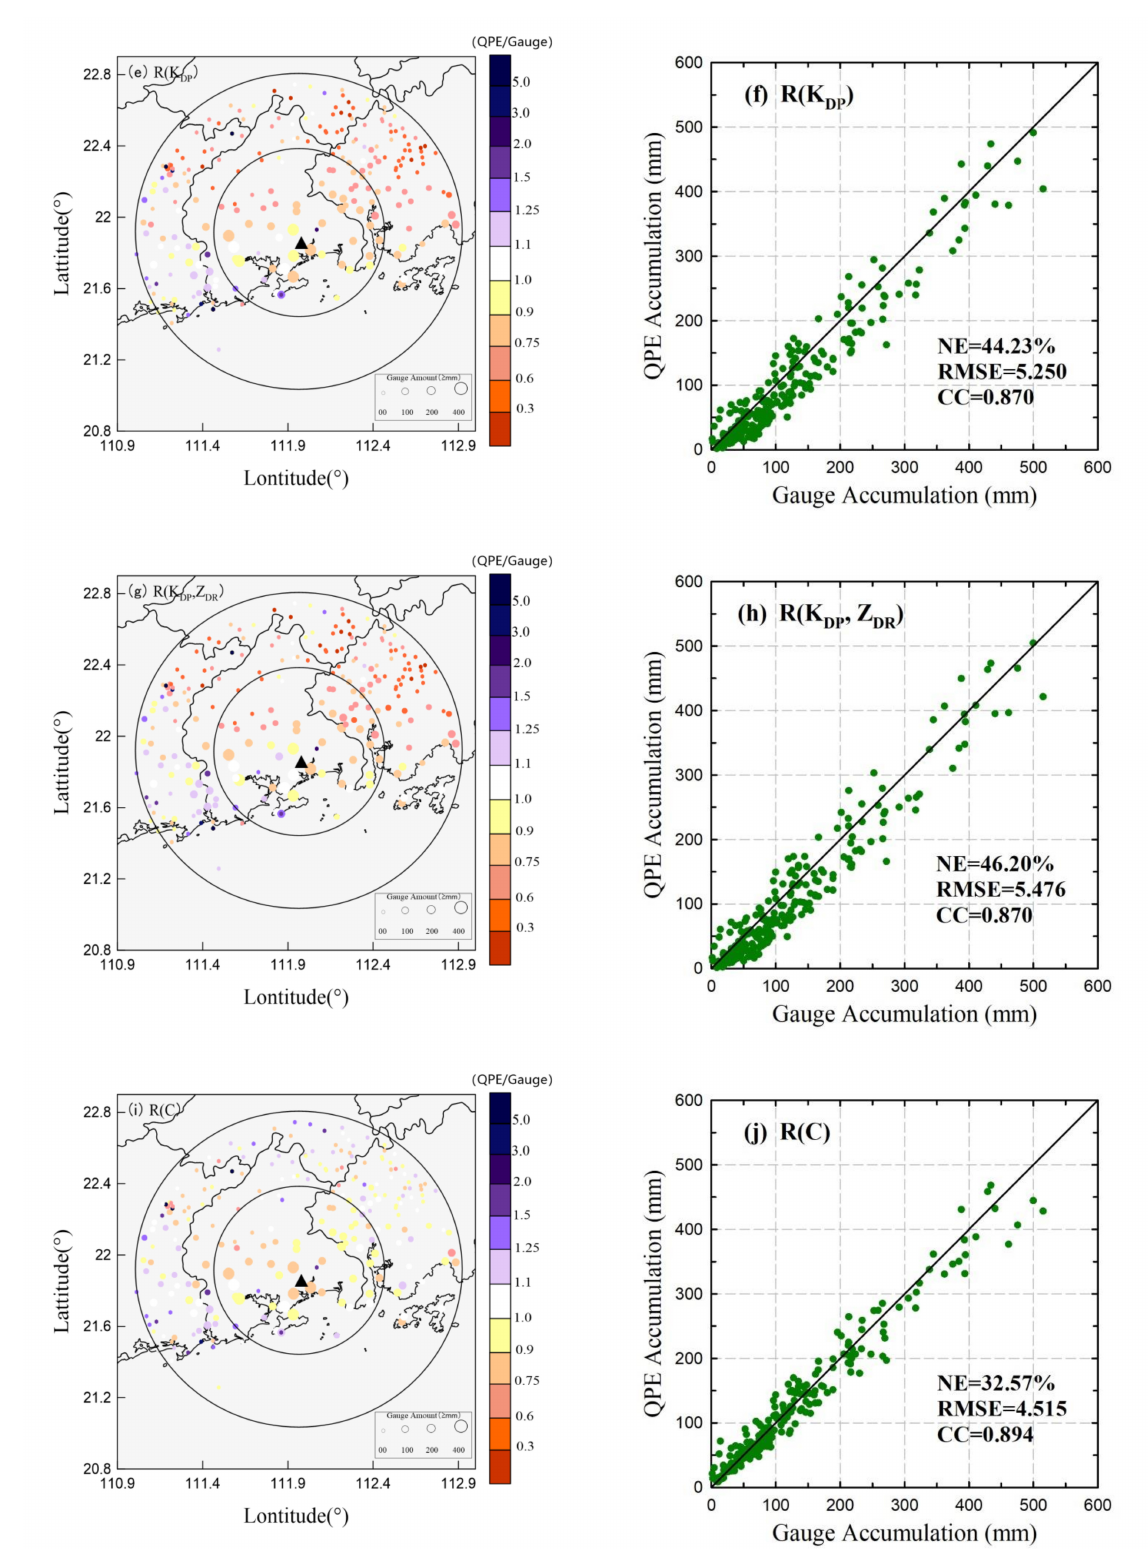
Figure 5. Comparison of YJ S-POL QPE results using R(Z H ), R(Z H , Z DR ), R(K DP ), R(K DP , Z DR ), and R(C) with rain gauge observations during monsoon rainfall event 6. The size of the circles in ( a , c , e , g , i ) indicate the rain gauge-observed accumulate rainfall, and the colors show the bias ratios (=R QPE /R RG ) between the QPES and rain gauge observations. Scatterplots in ( b , d , f , h , j ) show the QPE results vs the rain gauge